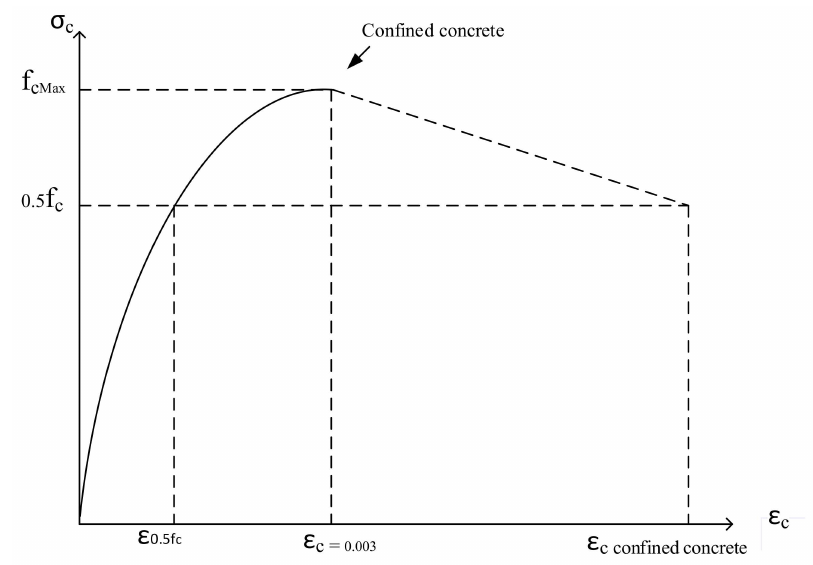
Figure 2. Typical stress–strain curves of unconfined and confined concrete.